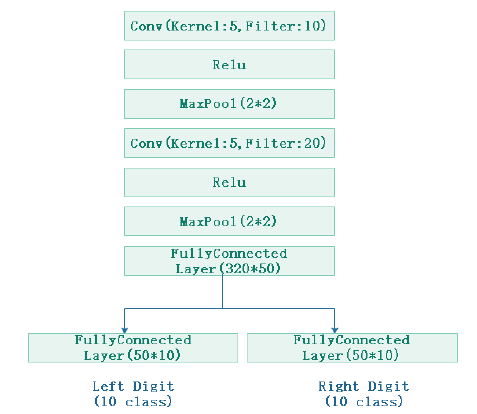
Figure 2. Structure diagram used as a MultiMNIST experiment.